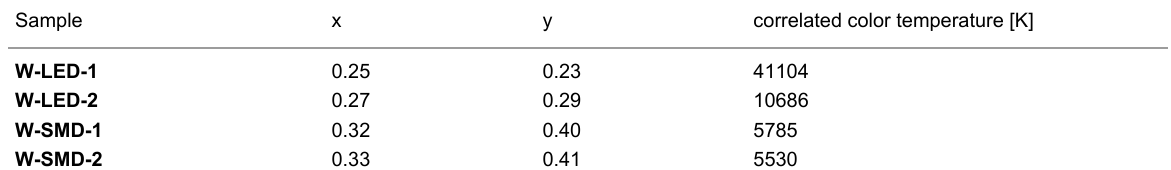
Table 3: CIE-coordinates x and y and correlated color temperatures of the four monolith coated LEDs. Sample